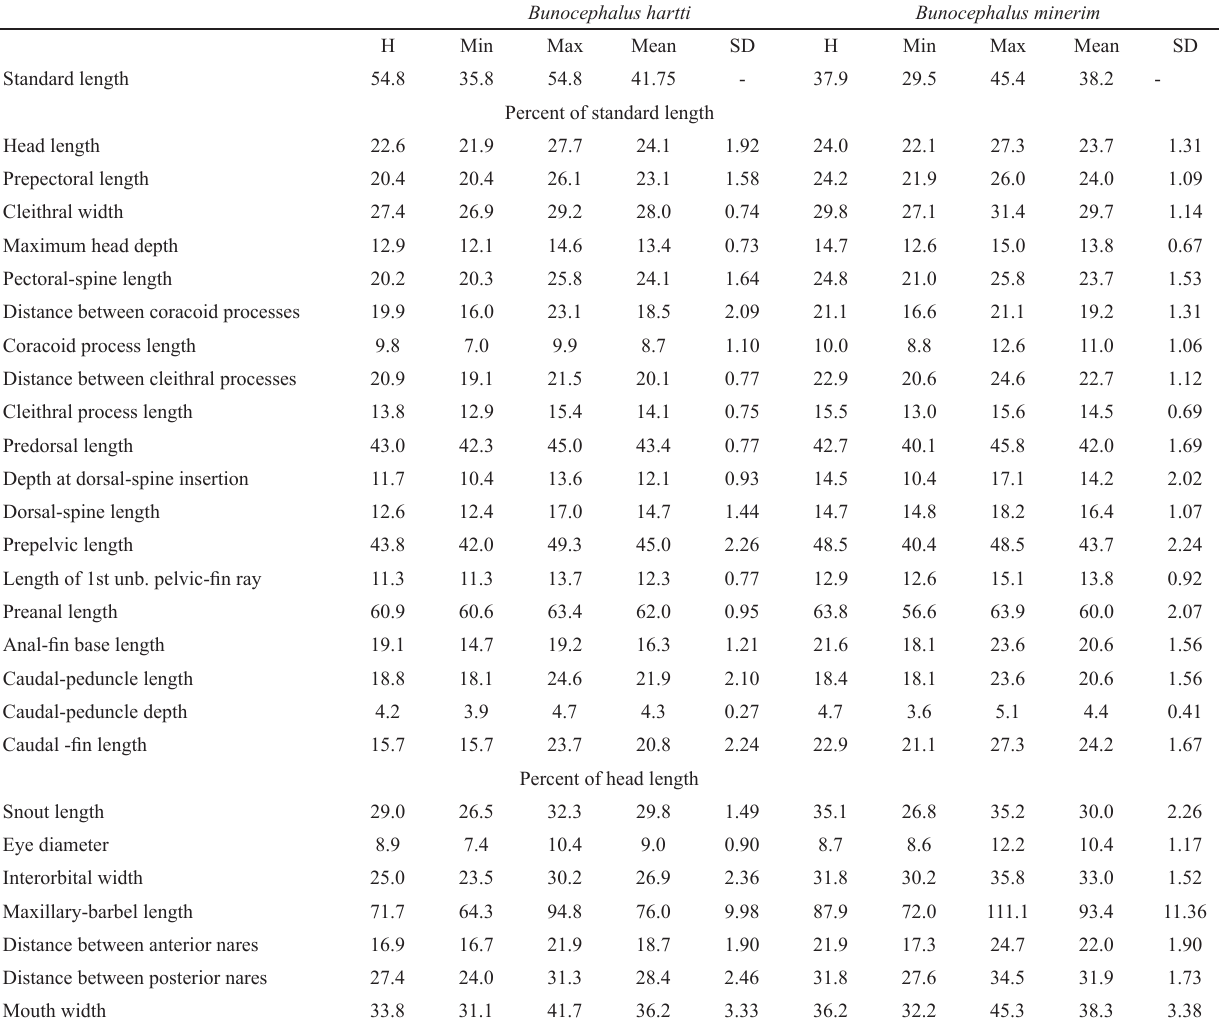
Table 1. Morphometric data of holotype and paratypes of Bunocephalus hartti (n=11 including the holotype) and Bunocephalus minerim (n=17 including the holotype). H= holotype; Max = maximum; Min = minimum; SD = standard deviation; and unb =